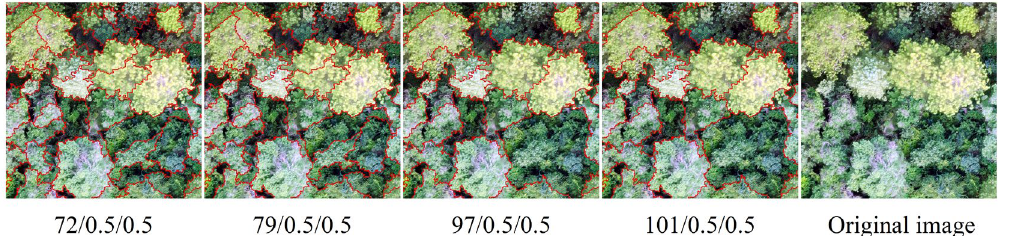
Figure 4. An alternative optimal scale segmentation effect of Shenxiantang tiankeng. The order of parameters is segmentation scale/shape/compactness. Red outlines represented the canopy contours formed by multi-scale segmentation. Visual interpretation of the overlap between the segmented outlines in red and the canopy shape of the original image. A high overlap indicated a good segmentation effect. If multiple canopies are within a red outline, it means under-segmentation; if a canopy is segmented by multiple red outlines, it means over-segmentation.